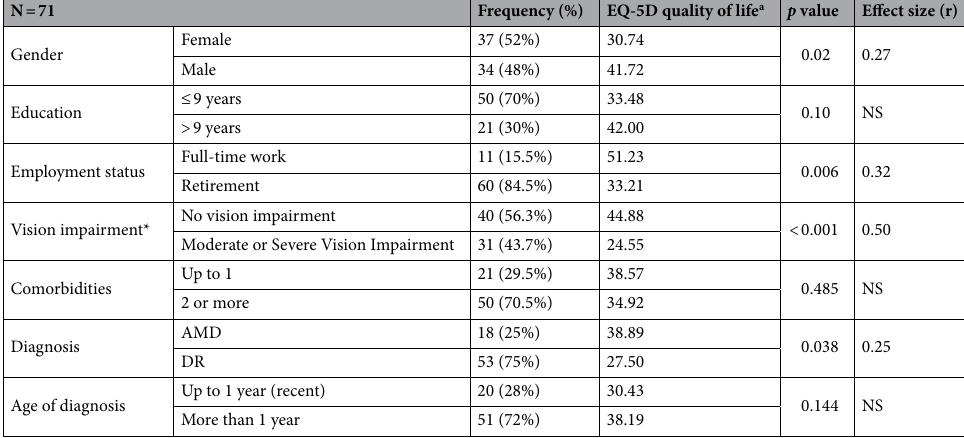
Table 2. Group comparisons for sample characteristics. AMD age-related macular degeneration, DR diabetic retinopathy, NS Not significant. *World Health Organization criteria for moderate or severe vision impairment which requires distance visual acuity to be worse than 6/18 or 0.477 logMAR. a Mean ranks obtained from Mann–Whitney U test.